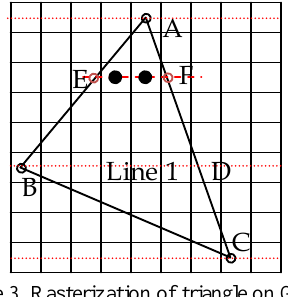
Figure 3. Rasterization of triangle on